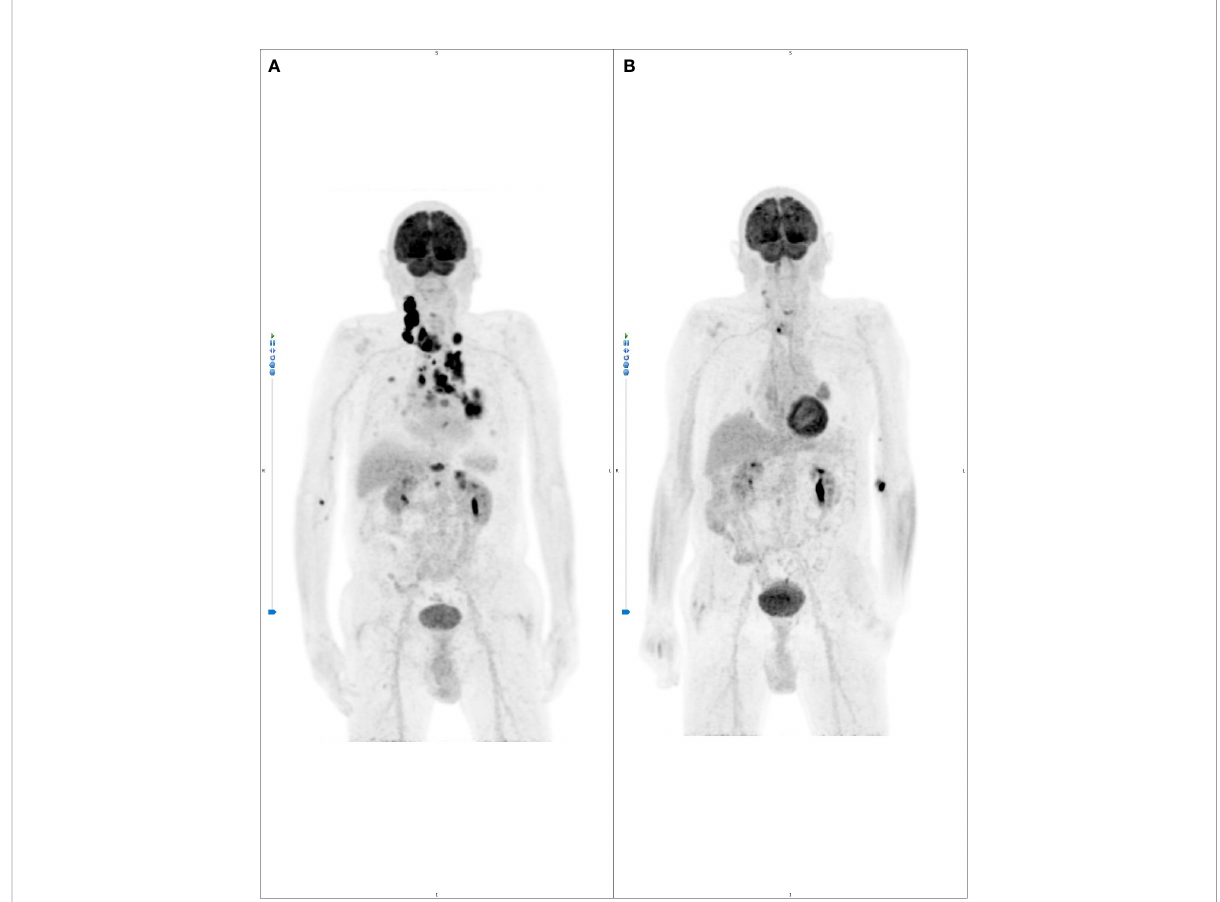
FIGURE 5 (A) basal 18FDG-PET scan showing intense signal in the right thyroid lobe (standardize uptake value, SUV max: 23.7), right neck metastasis (SUV max: 44.5), bilateral supraclavicular lymph nodes (SUV max: 31, right; SUV max: 15., left), lung nodules (Left lower lobe, SUV max: 15.1- Posterior and 17.0-Paravertebral; Right upper lobe, SUV max: 6.5 and 6.2), mediastinal lymph nodes (left pulmonary hilus, SUV max: 10.4; left peribronchial, bilateral tracheo-bronchial and subcarinal, SUV max: 7.3), upper thoracic outlet, paraesophageal, right para-tracheal lymph nodes